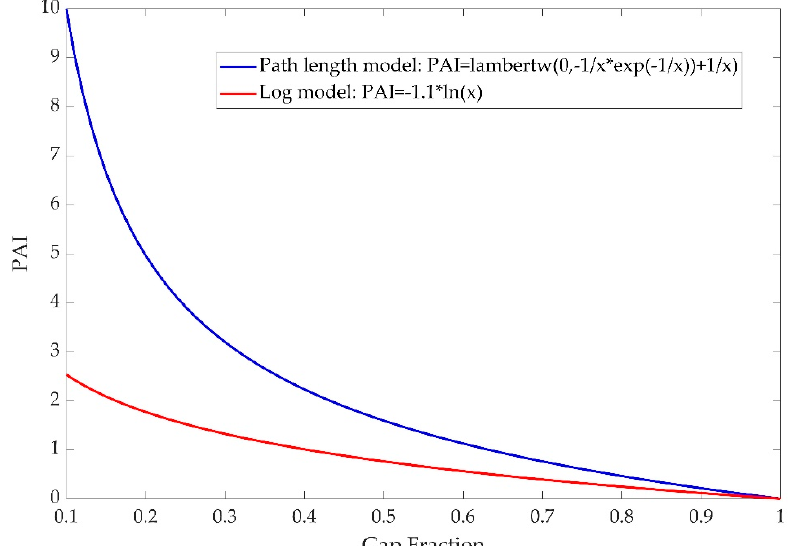
Figure 13. Relationship between gap fraction and PAI (or LAI). The red curve shows PAI values from the path length distribution model, compared to the blue curve from the simple Beer’s law model. Detailed mathematic functions are provided in the legend, with x representing the gap fraction.